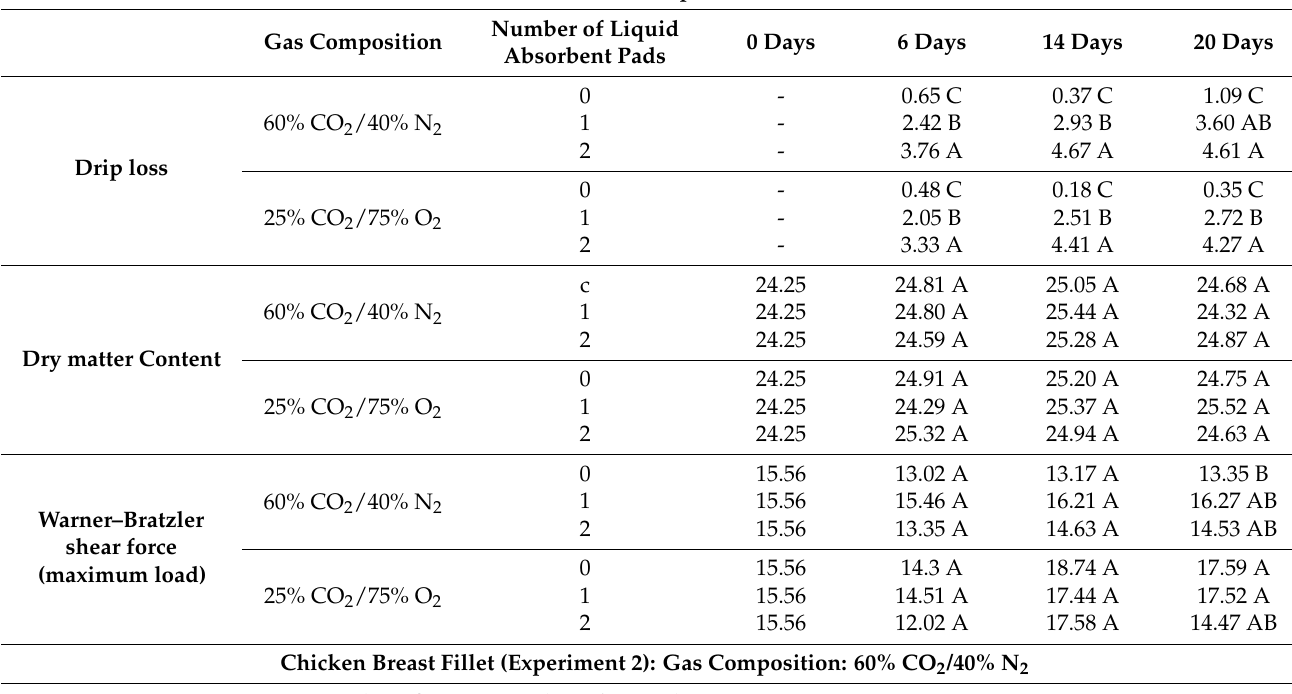
Table A2. One-way analyses of variance for drip loss, dry matter content and Warner–Bratzler shear force (N/cm 2 ) (maximum load) for each recorded day of storage of chicken breast fillets (Experiment 1). The one-way ANOVAs were computed by defining a six-level factor with the combinations of gas composition and liquid absorbent pads. Tukey’s letters signify which of the six combinations of gas composition and liquid absorbent pad numbers are not significantly different ( p -value > 0.05), i.e., levels sharing a letter are not significantly different. In the lower part of the table (Experiment 2), gas volume/product volume replaces gas composition.